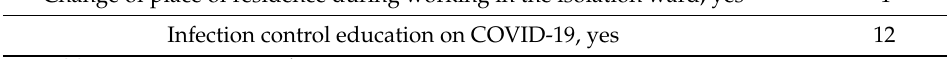
Table 1. Cont. Variables N Change of place of residence during working in the isolation ward, yes 4 Infection control education on COVID-19, yes 12 Note. COVID-19 = coronavirus